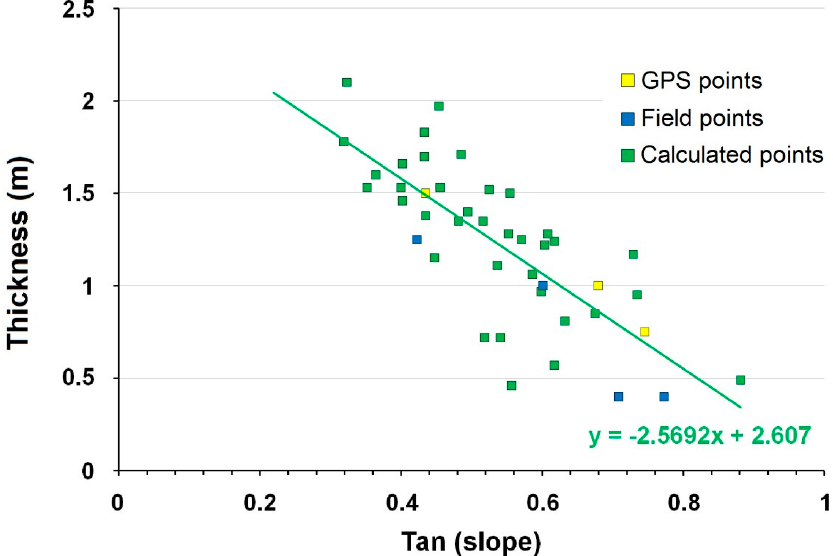
Figure 6. Thickness model of the surficial cover resulting from the application of the modified version of the method proposed by [26]. The three different types of thickness data used as constraints of the model are also reported.